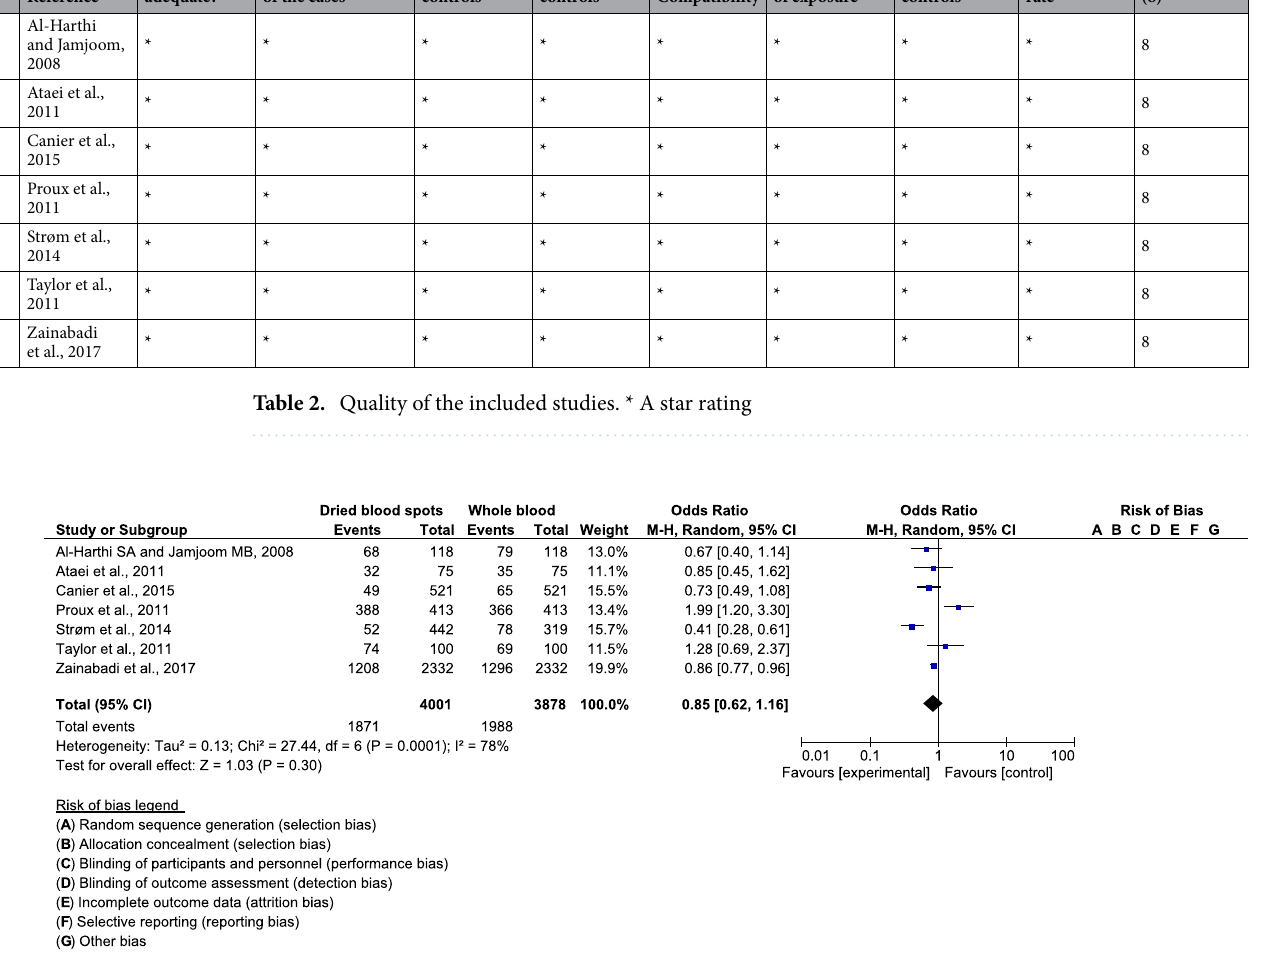
Figure 2. Forrest plot demonstrated the performance of polymerase chain reaction using deoxyribonucleic acid from dried blood spots and whole